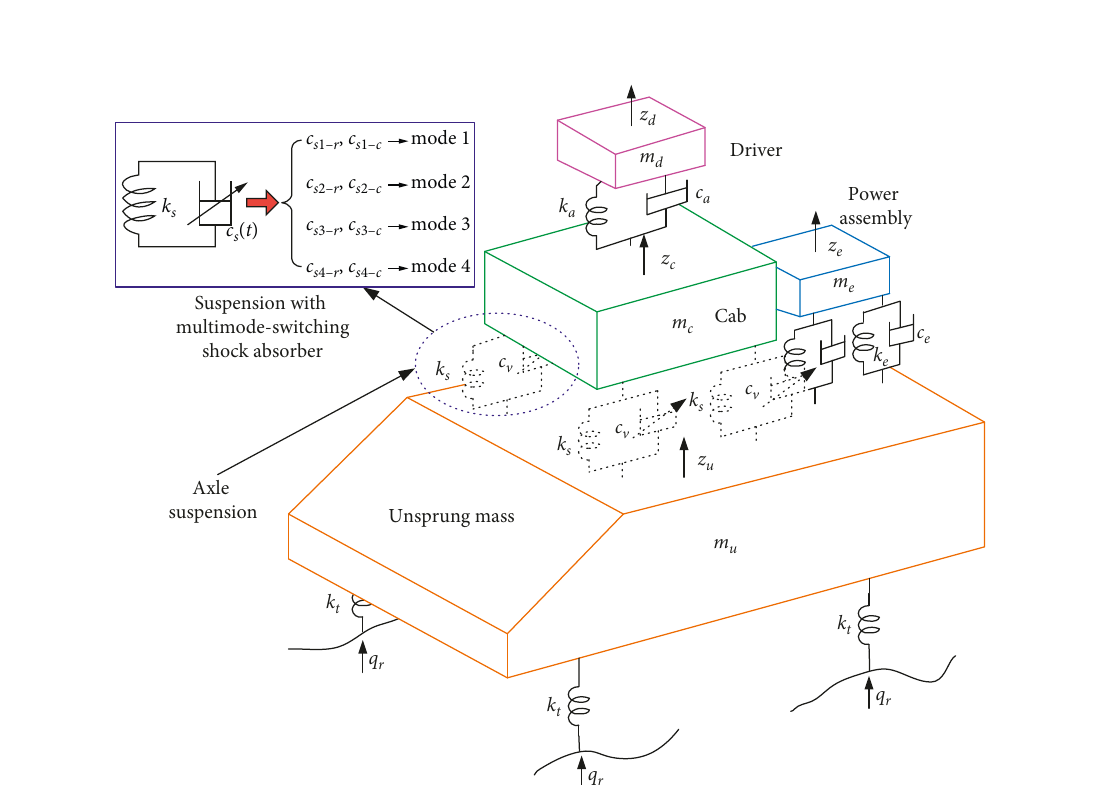
Figure 4: Vibration model of the wheel loader with the target shock absorber.